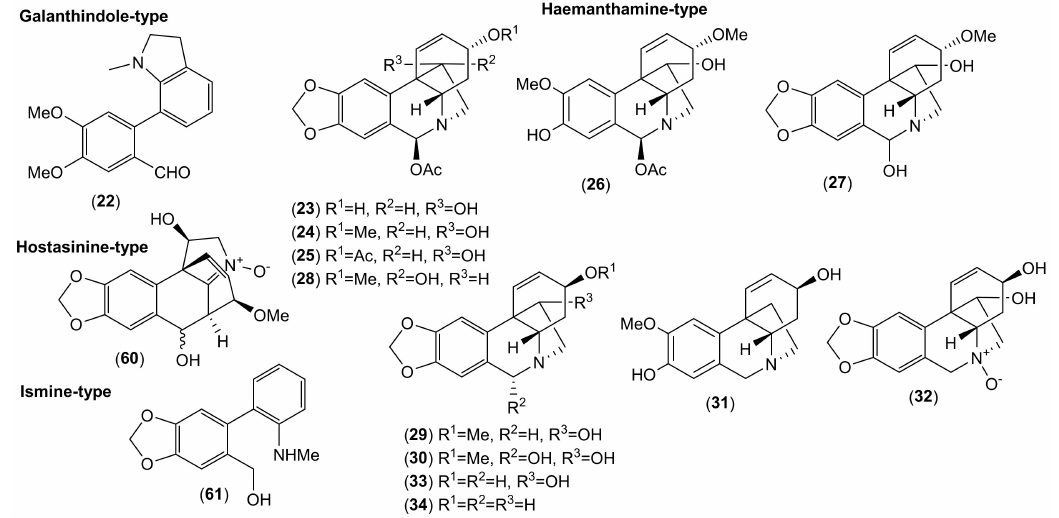
Figure 2. Amaryllidaceae alkaloids of galanthindole-, haemanthamine-, hostasinine-, and ismine-type reported in Lycoris